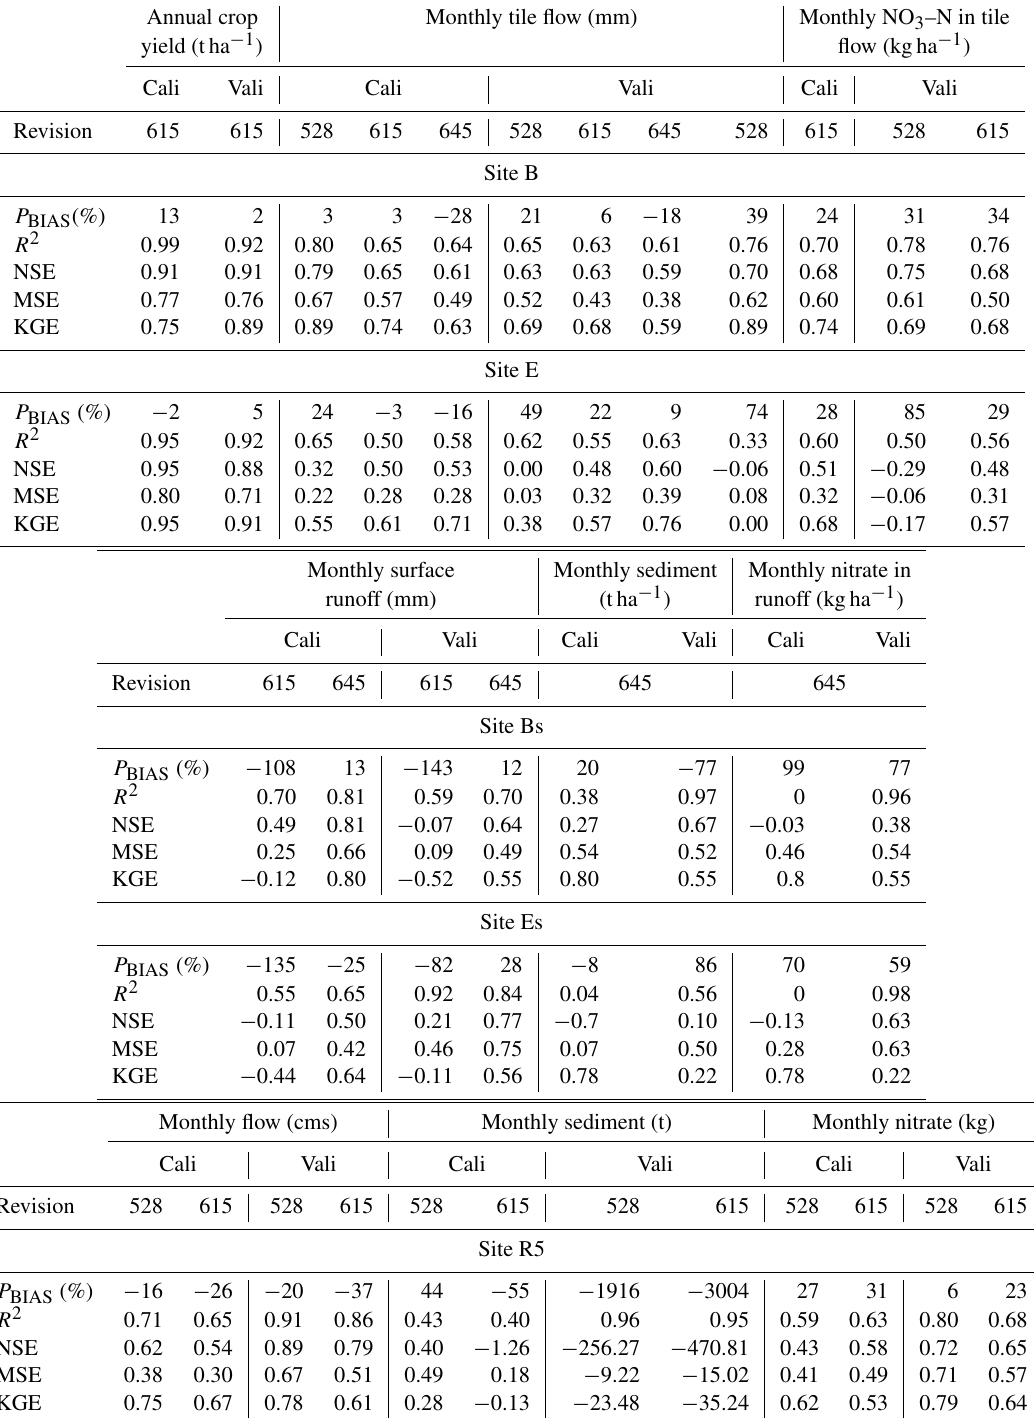
Table 4. Performance evaluation of the calibrated and validated results at sites B, E, Bs, Es, and